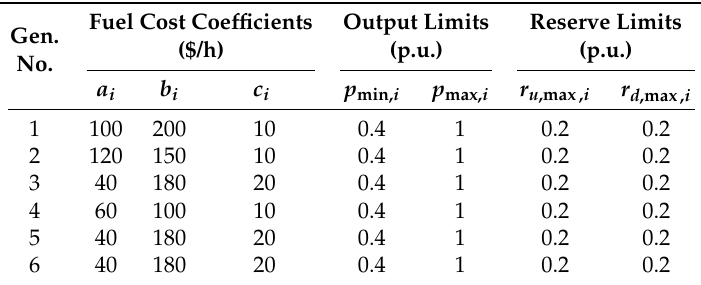
Table 2. Parameters of the conventional thermal